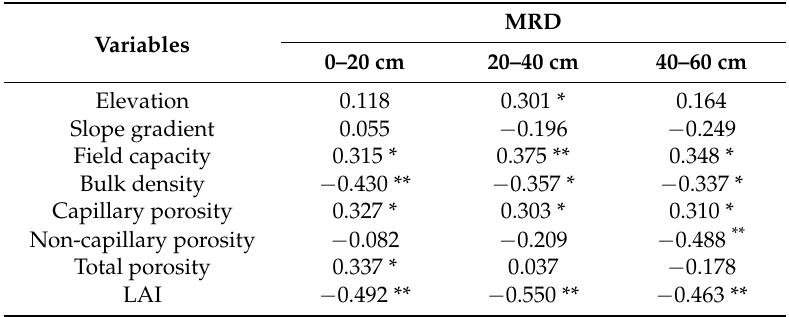
Table 3. The correlations between mean relative difference (MRD) and topographic, soil physical, and vegetation structure factors for three soil